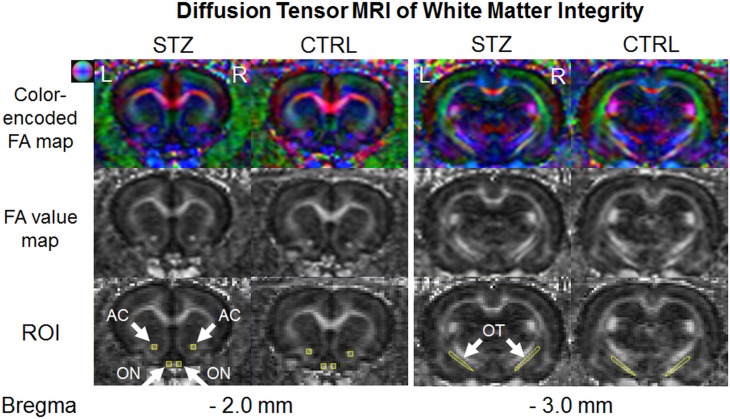
Diffusion tensor MRI of white matter integrity in the prechiasmatic optic nerve (ON), optic tract (OT) and anterior commissure (AC) (arrows).(Top row) Color-encoded fractional anisotropy (FA) directionality maps; (Middle row) FA value maps; (Bottom row) Illustrations of the regions of interest (ROI) in yellow at the corresponding Bregma locations for quantitative analyses. Note the relatively lower FA in the optic nerves of the streptozotocin (STZ) group compared to the sham control (CTRL) group. Color ball illustrates the corresponding principal diffusion directions in the color-encoded FA directionality map: blue: caudal-rostral; red: left-right; and green: dorsal-ventral.